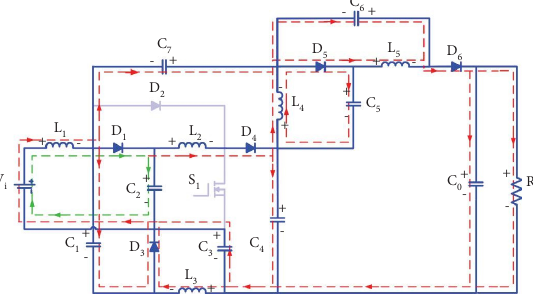
Figure 4: Equivalent circuit of the proposed converter in mode II (second